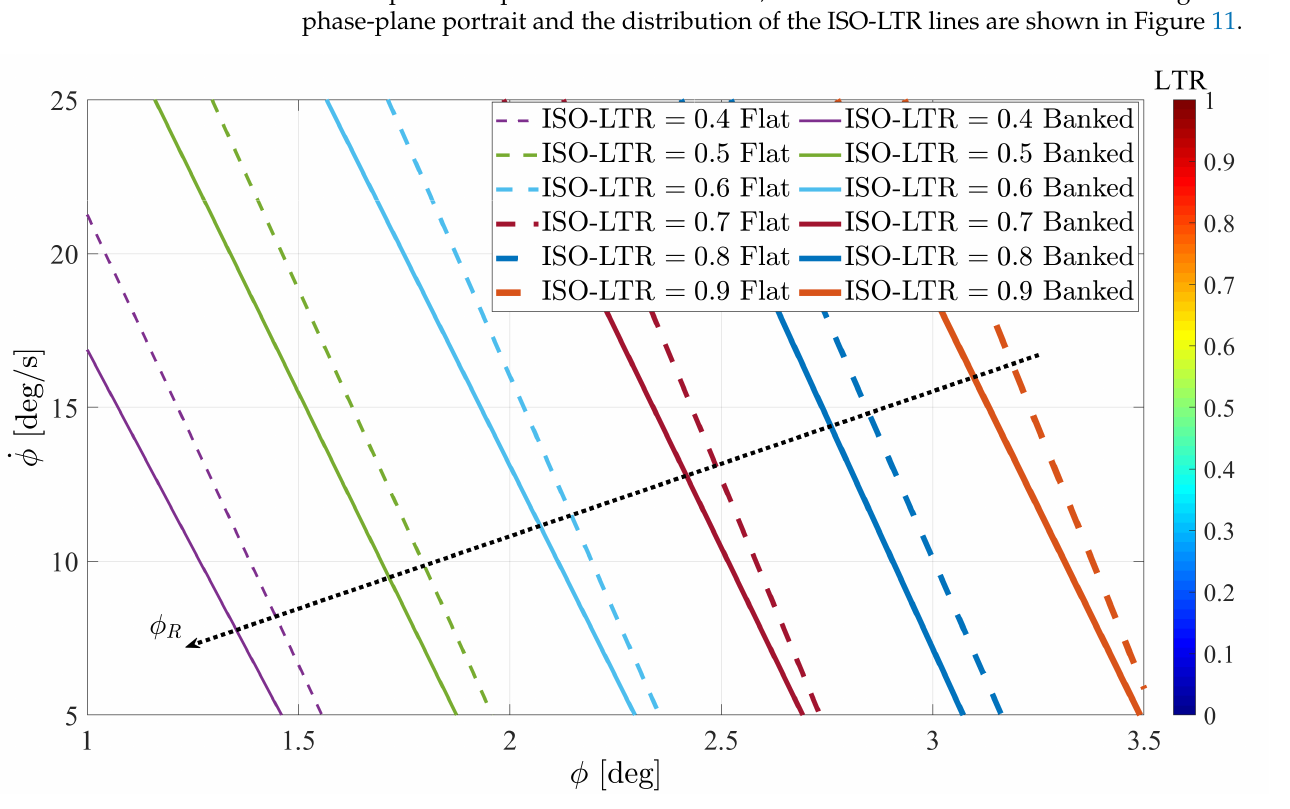
Figure 11. Comparison of the ISO-LTR characteristics for a flat and a 10deg banked